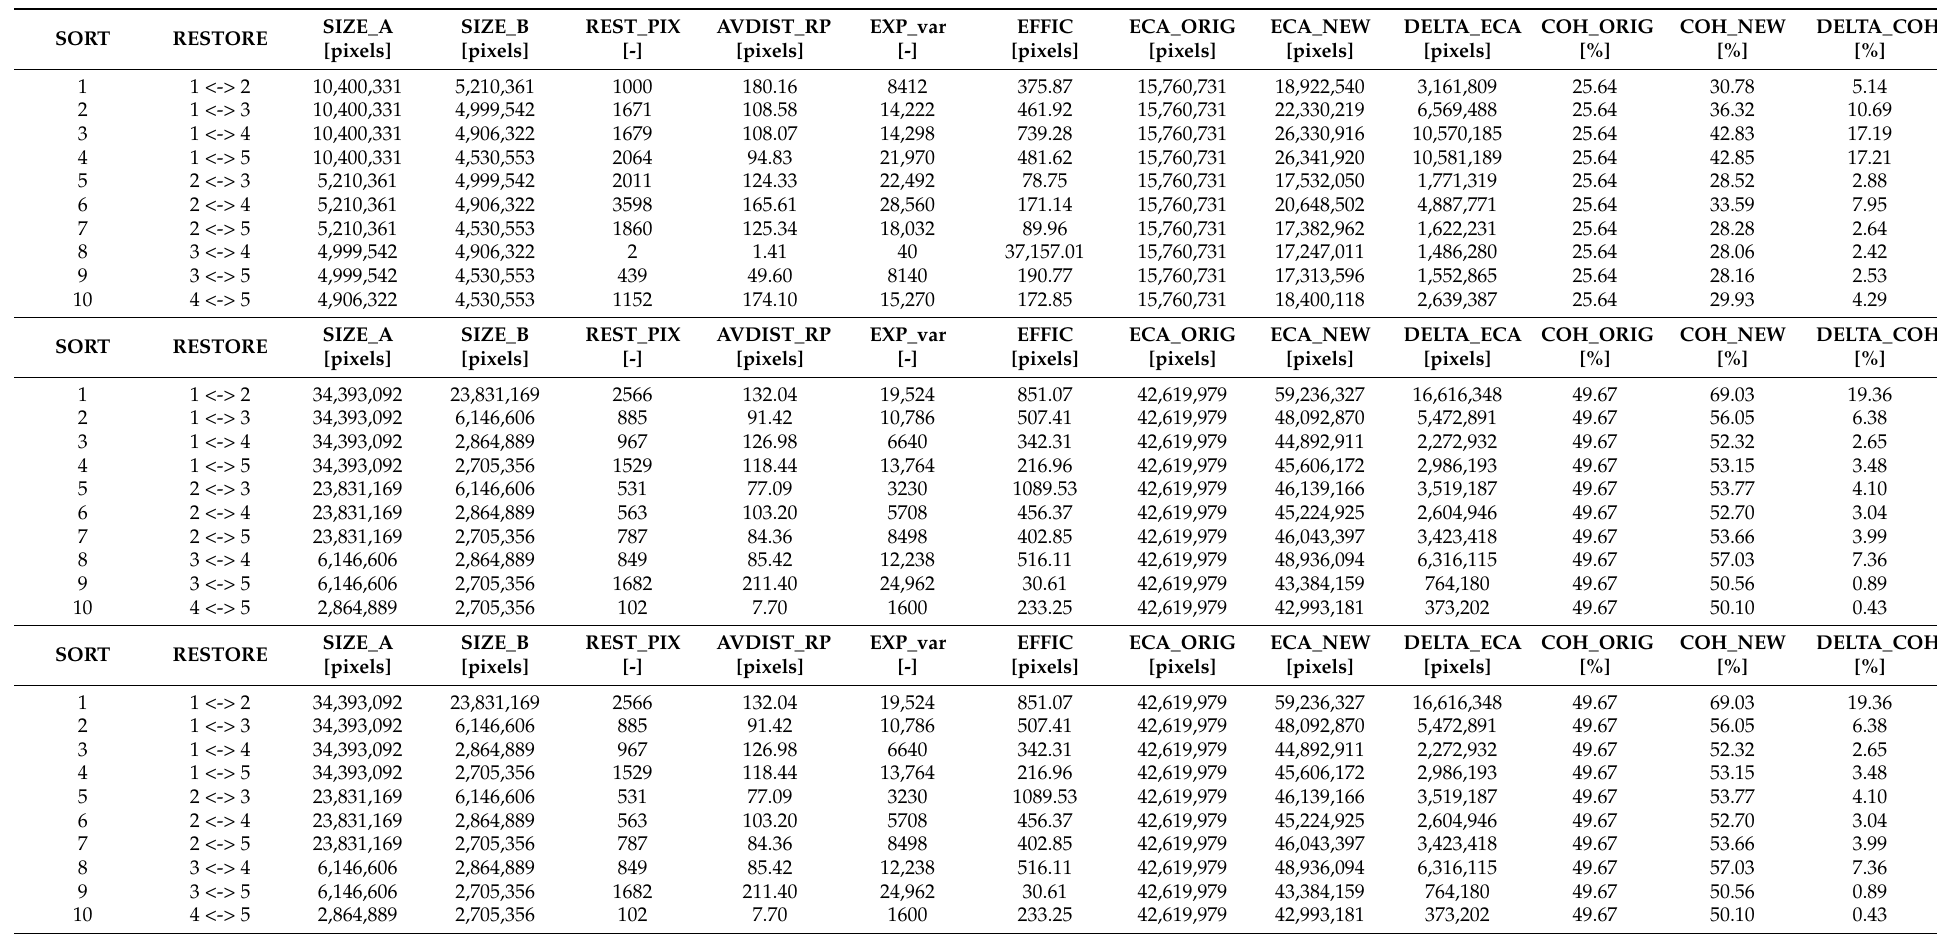
Table 2. Tabular summary statistics for the ten restoration pathways between the five largest network objects for Natura 2000 (top), Level 0 (center), and Level 1